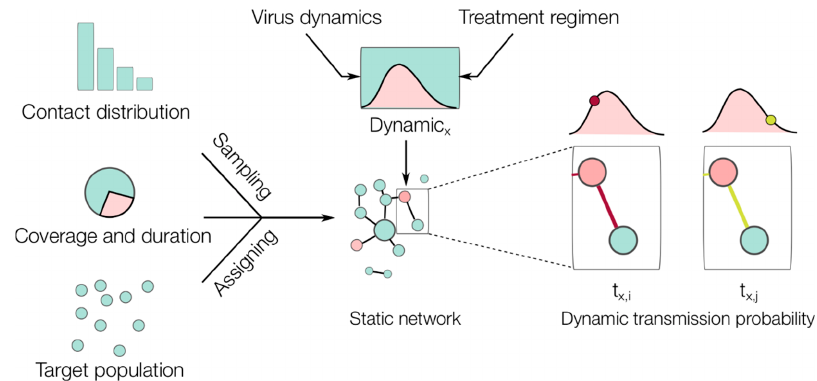
Figure 2. Illustration of the epidemic network model simulations. Based on empirical contact distribution data, the number of contacts (edges) was sampled and assigned to each subject (node). Based on the coverage and duration of the intervention, the nodes were assigned to either taking the drug in the defined period or not. Based on the within-host model, each infected node xth (colored red in the network) will have its own viral dynamics (red area in the dynamic) depending on whether it was already taking the drug at the time of infection or not. The transmission between infected and uninfected nodes (colored blue in the network) was evaluated in every simulation time step (e.g., i and j), during which the transmission probability varied (indicated by the edge’s color intensity) following the infection dynamics of the infected subject under consideration (see Section 2.3, Software and Algorithms, for further